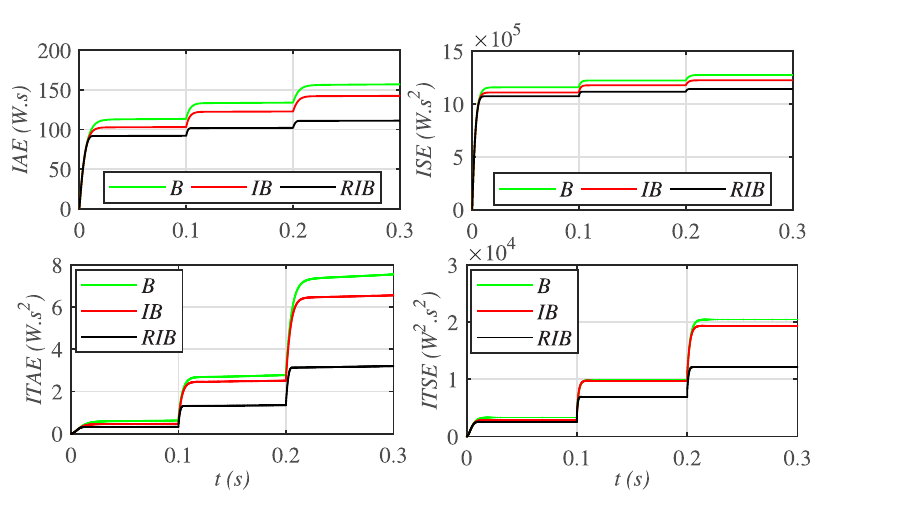
Fig 14. Performance indices comparison under case 1.